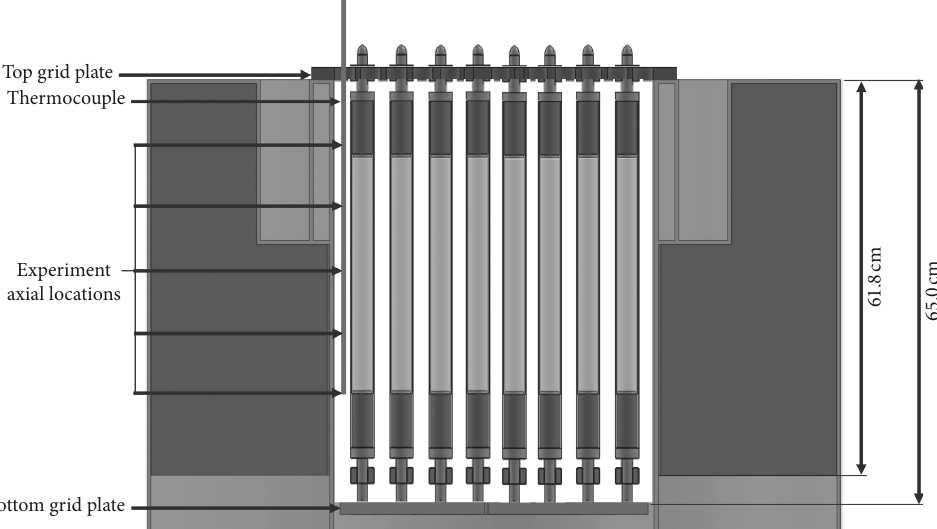
Bottom grid plate Figure 18: Vertical positions of the